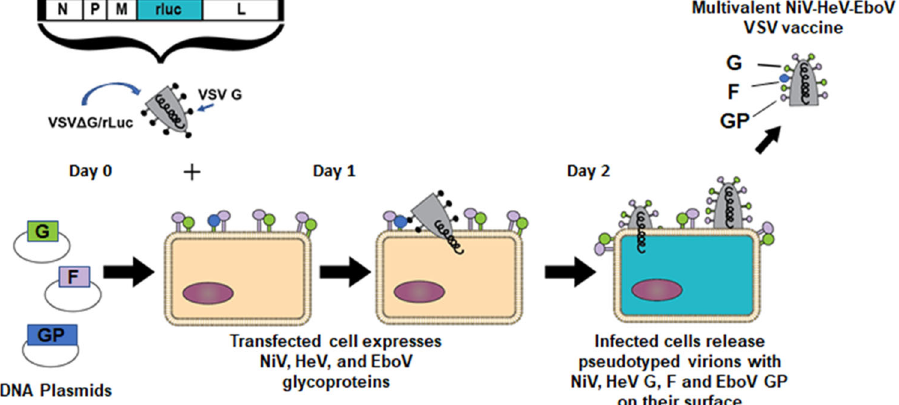
Fig. 3 Pseudotyped virion production system. A diagram showing transfection of HEK 293T cells using plasmids carrying DNA encoding for the immunogenic proteins of interest, followed by infection using VSV-deltaG virus. The subsequent pseudotyped VSV virion preparation carries all fi ve distinct viral glycoproteins and can be used as a multivalent